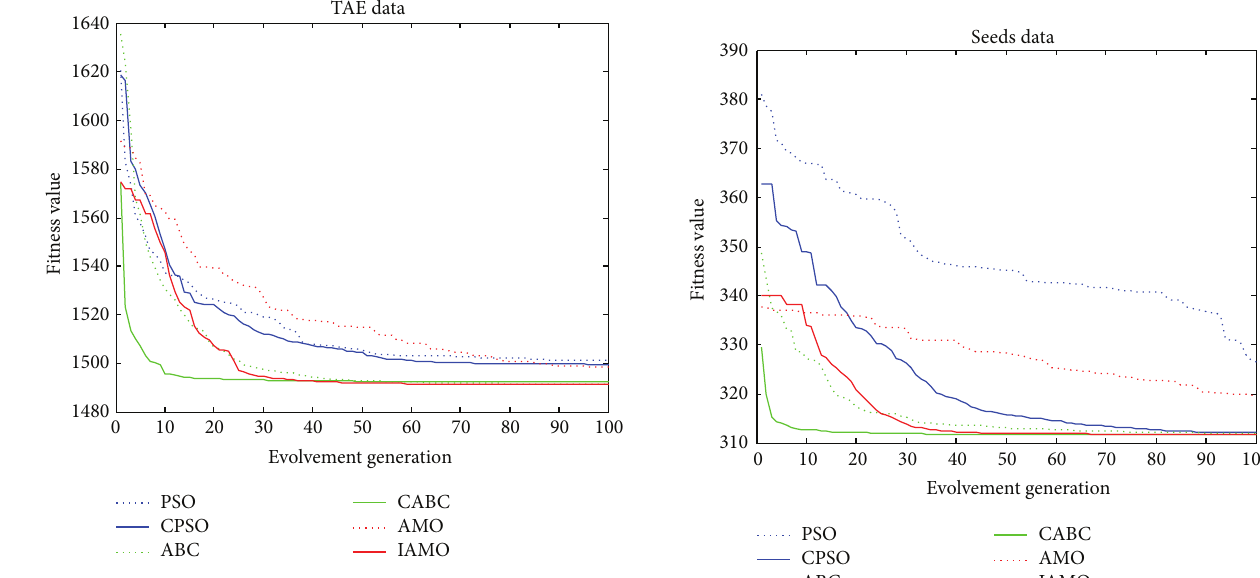
Figure 8: The convergence curve of the TAE data.